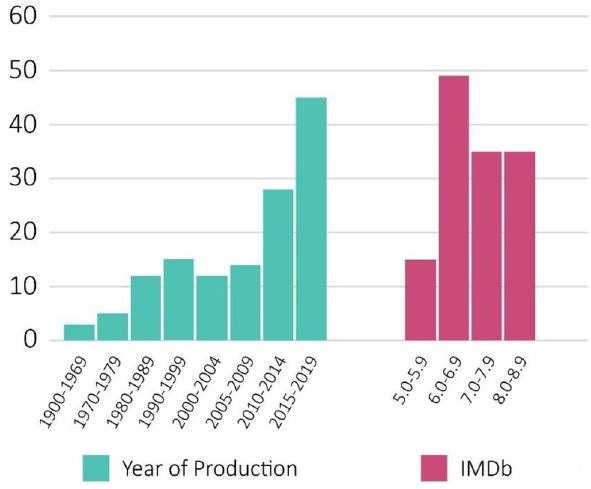
Fig. 1 Chart of the movies’ year of production and IMDb